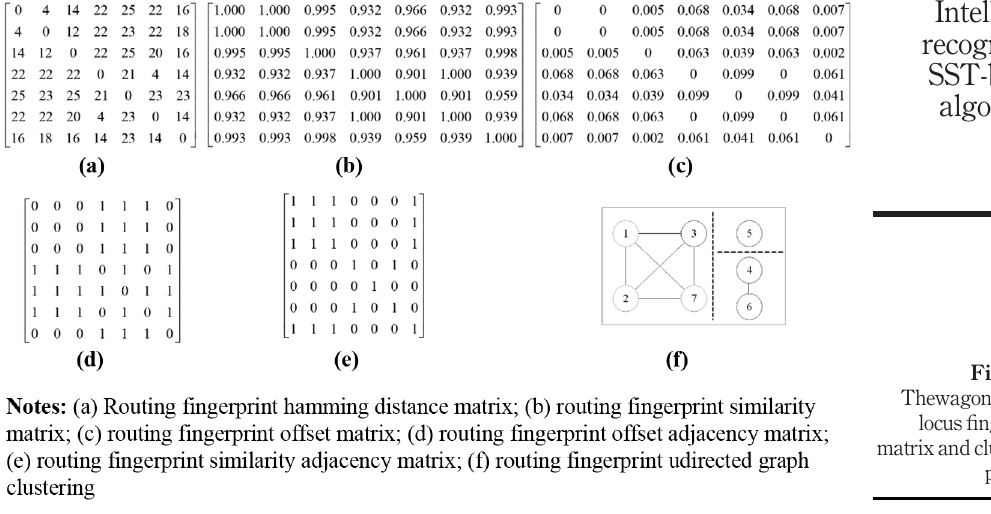
Figure 8. Thewagon routing